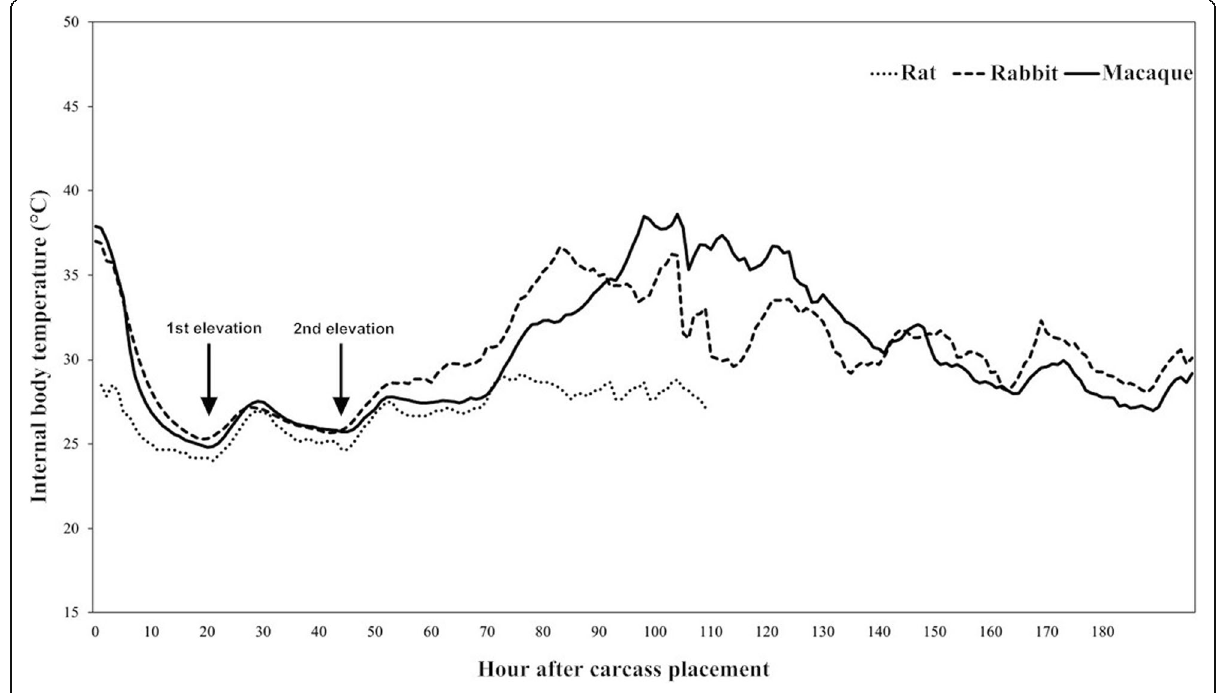
Fig. 1 Data logger reading of hourly body temperature (°C) showing two elevation points in rat, rabbit, and macaque carcasses